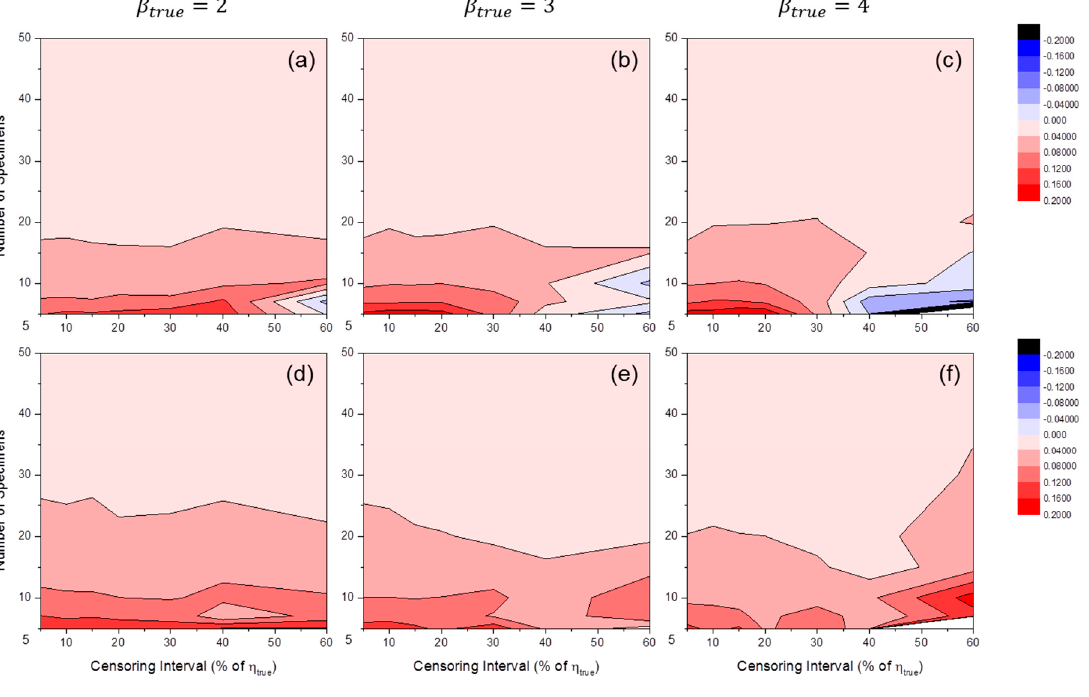
Figure 7. Distributions of SE (cid:2873)(cid:2868)% ((cid:2010)(cid:4632) (cid:3014)(cid:3013)(cid:3006) ) at: ( a ) (cid:2010) (cid:3047)(cid:3045)(cid:3048)(cid:3032) = 2 ; ( b ) (cid:2010) (cid:3047)(cid:3045)(cid:3048)(cid:3032) = 3 ; and ( c ) (cid:2010) (cid:3047)(cid:3045)(cid:3048)(cid:3032) = 4 ; and Figure 7. Distributions of SE 50% p ˆ β MLE q at: ( a ) β true “ 2; ( b ) β true “ 3; and ( c ) β true “ 4; and SE (cid:2873)(cid:2868)% ((cid:2010)(cid:4632) (cid:3014)(cid:3019)(cid:3019) ) at: ( d ) (cid:2010) (cid:3047)(cid:3045)(cid:3048)(cid:3032) = 2 ; ( e ) (cid:2010) (cid:3047)(cid:3045)(cid:3048)(cid:3032) = 3 ; and ( f ) (cid:2010) (cid:3047)(cid:3045)(cid:3048)(cid:3032) = 4 (test duration: 120% of (cid:2015) (cid:3047)(cid:3045)(cid:3048)(cid:3032) ). SE 50% p ˆ β MRR q at: ( d ) β true “ 2; ( e ) β true “ 3; and ( f ) β true “ 4 (test duration: 120% of η true